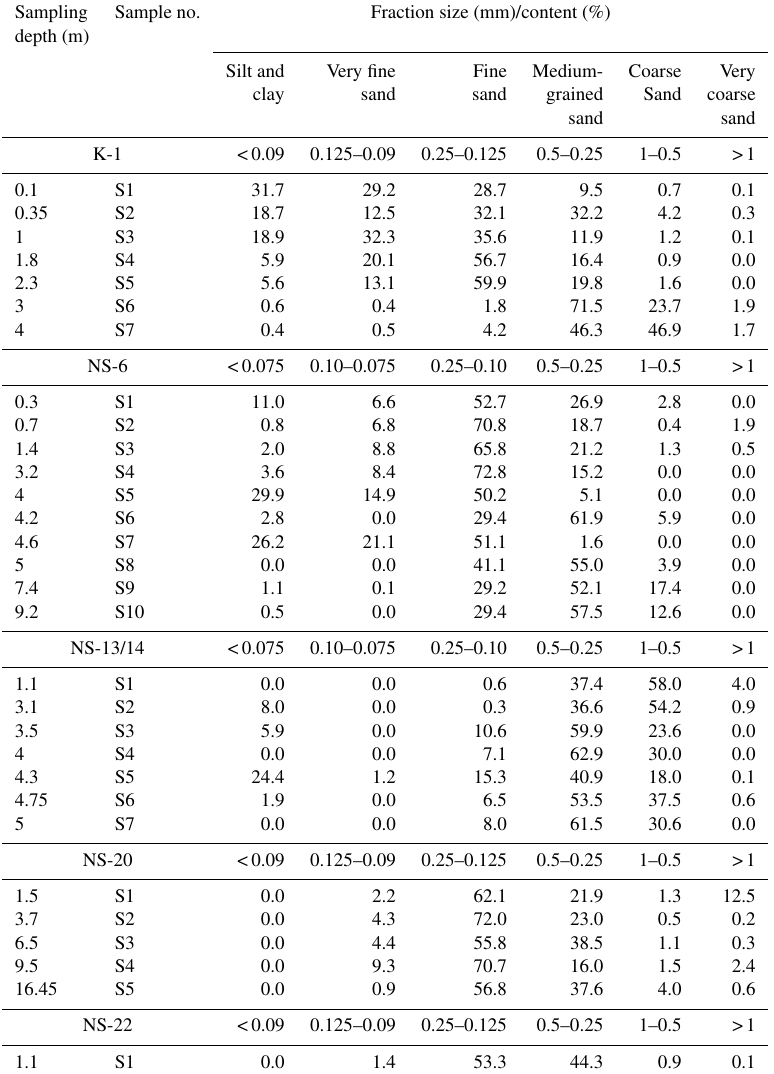
Table A3. Grain size